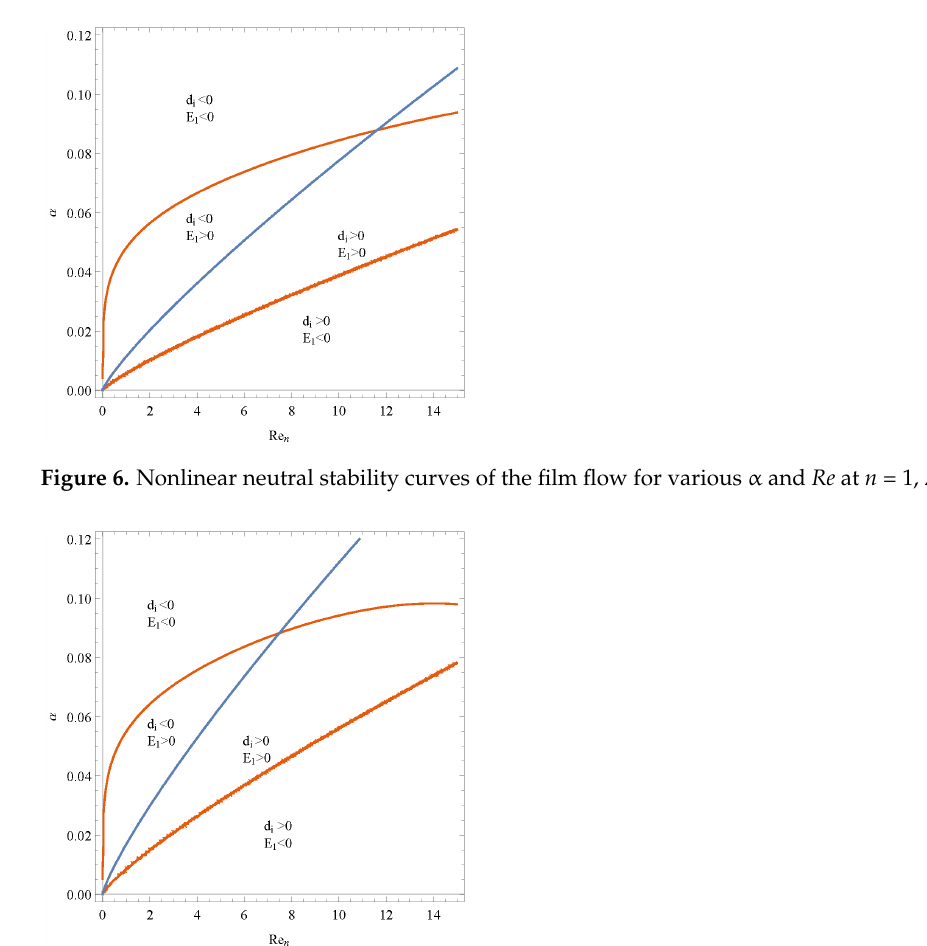
Figure 5. Nonlinear neutral stability curves of the film flow for various α and Re at n = 1.05, Z = 0.51.